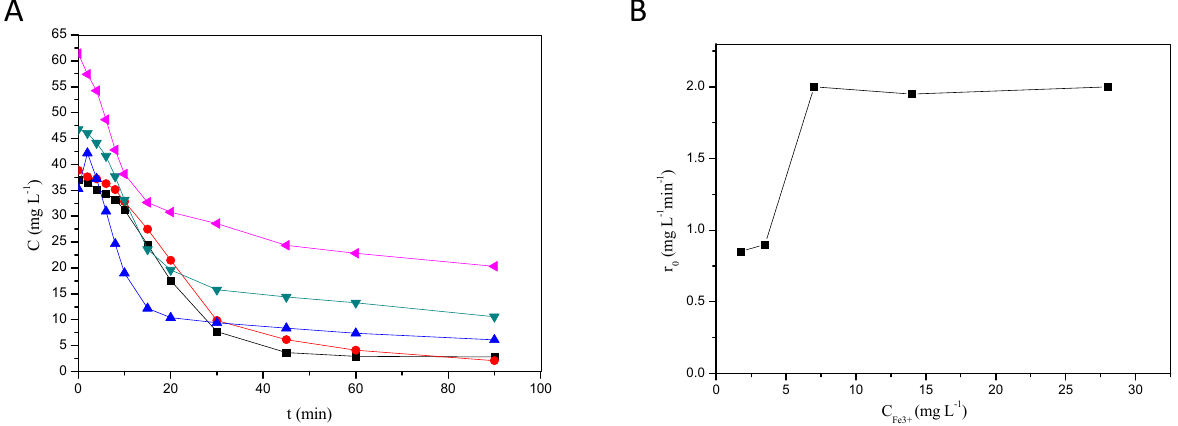
Figure 2. ( A ) Photocatalytic degradation of 40 mg L − 1 CLPR with photo-Fenton reagent in the presence of 100 mg L − 1 H 2 O 2 and: [ ■ ] 2 mg L − 1 Fe 3+ , ( ● ) 3.5 mg L − 1 Fe 3+ , ( ▲ ) 7 mg L − 1 Fe 3+ , ( ▼ ) 14 mg L − 1 Fe 3+ , ( ◄ ) 28 mg L − 1 Fe 3+ ; ( B ) change in the initial degradation rate of CLPR with photo-Fenton reagent in the presence of 100 mg L − 1 H 2 O 2 and different concentrations of Fe 3+ .